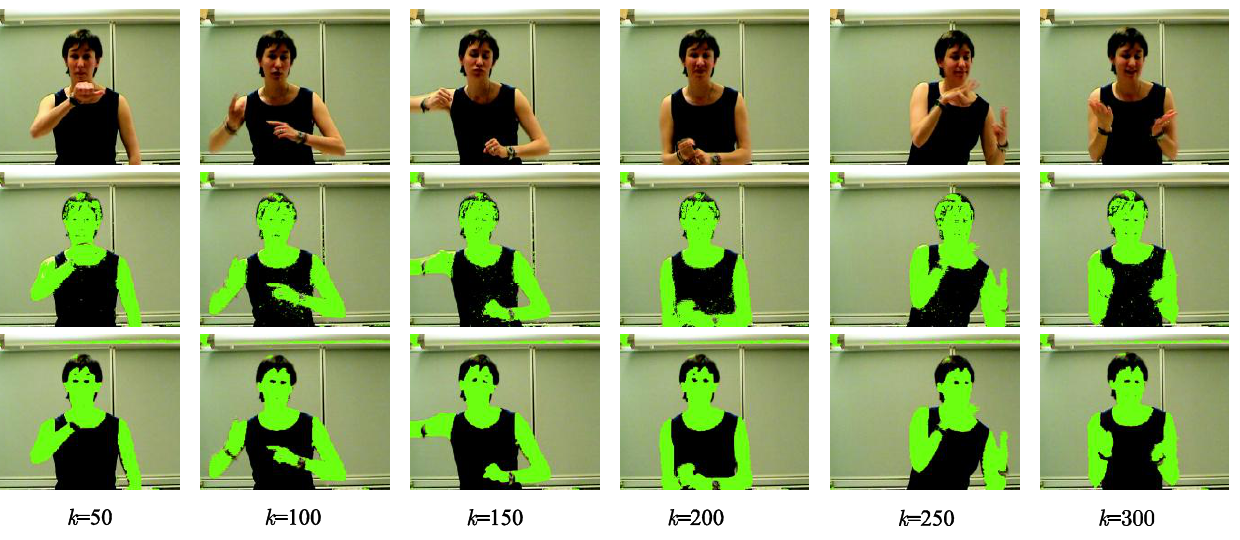
Figure 17. Segmentation results of 6 frames of an image sequence of a person generating sign language with small temporal illumination